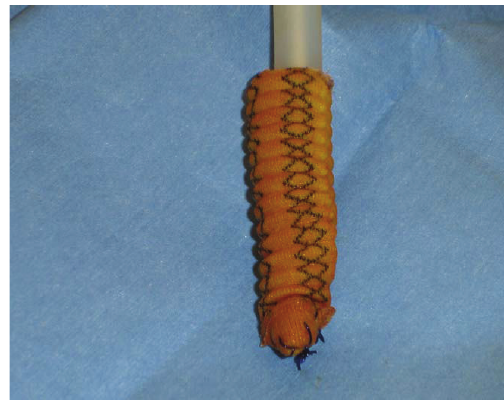
Figure 1: A dacron sock created around the tip of a malleable prosthesis in a case of proximal corpus cavernosum